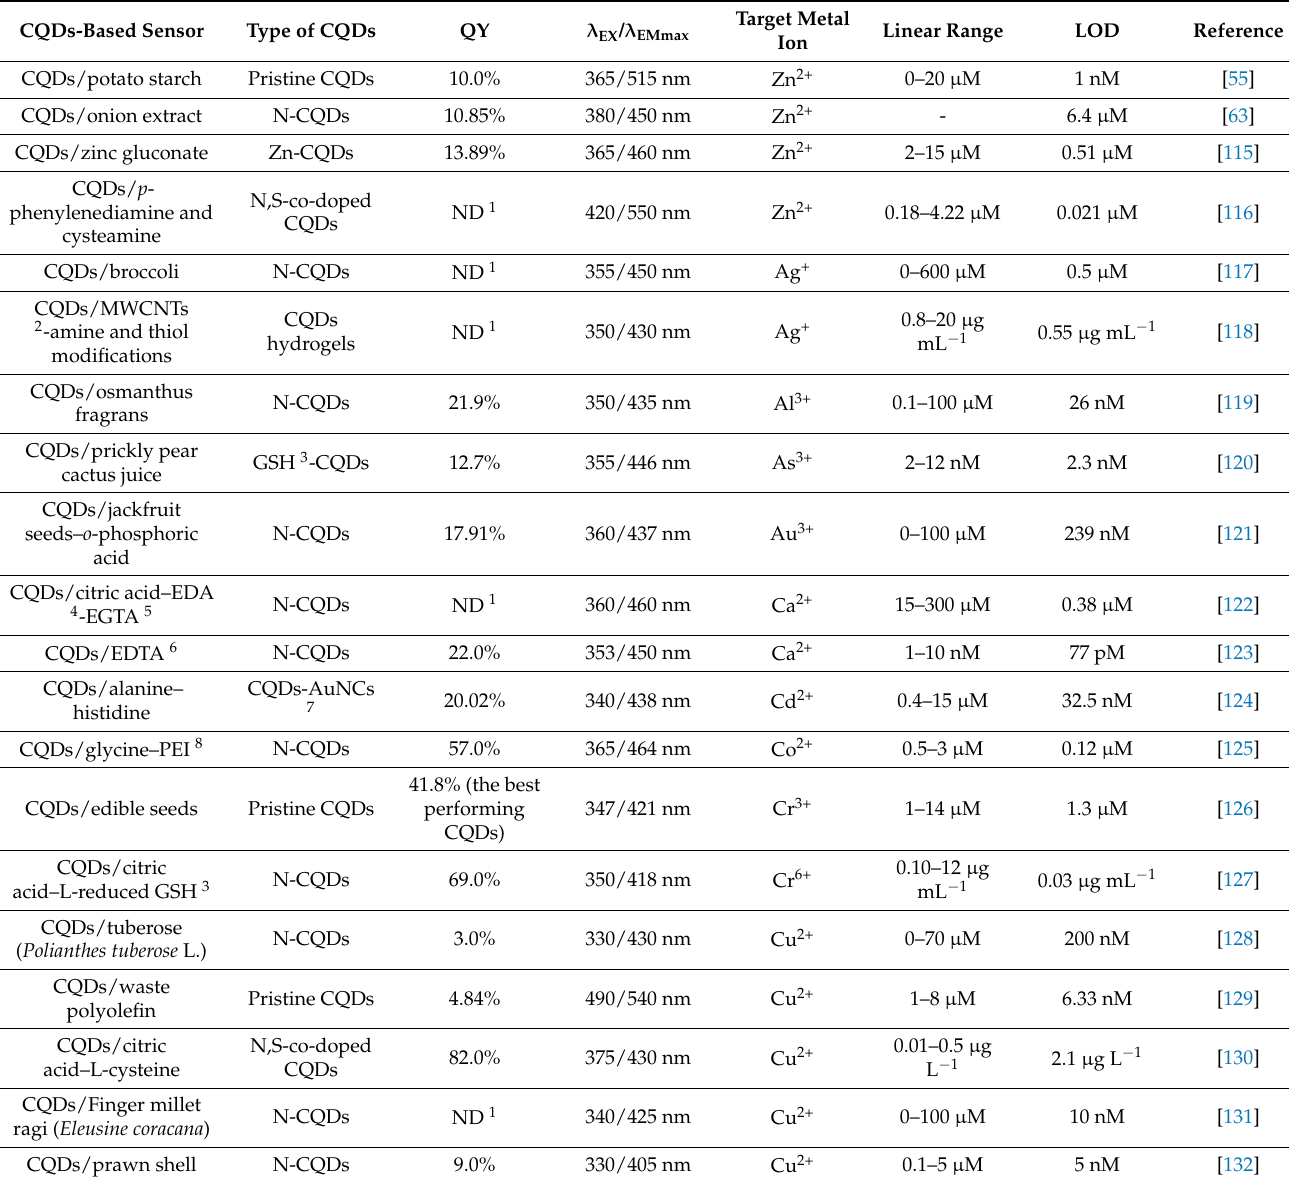
Table 5. Summary of the literature reporting methods of miscellaneous metal ions detection of the past five years (2016–2021). CQDs-Based